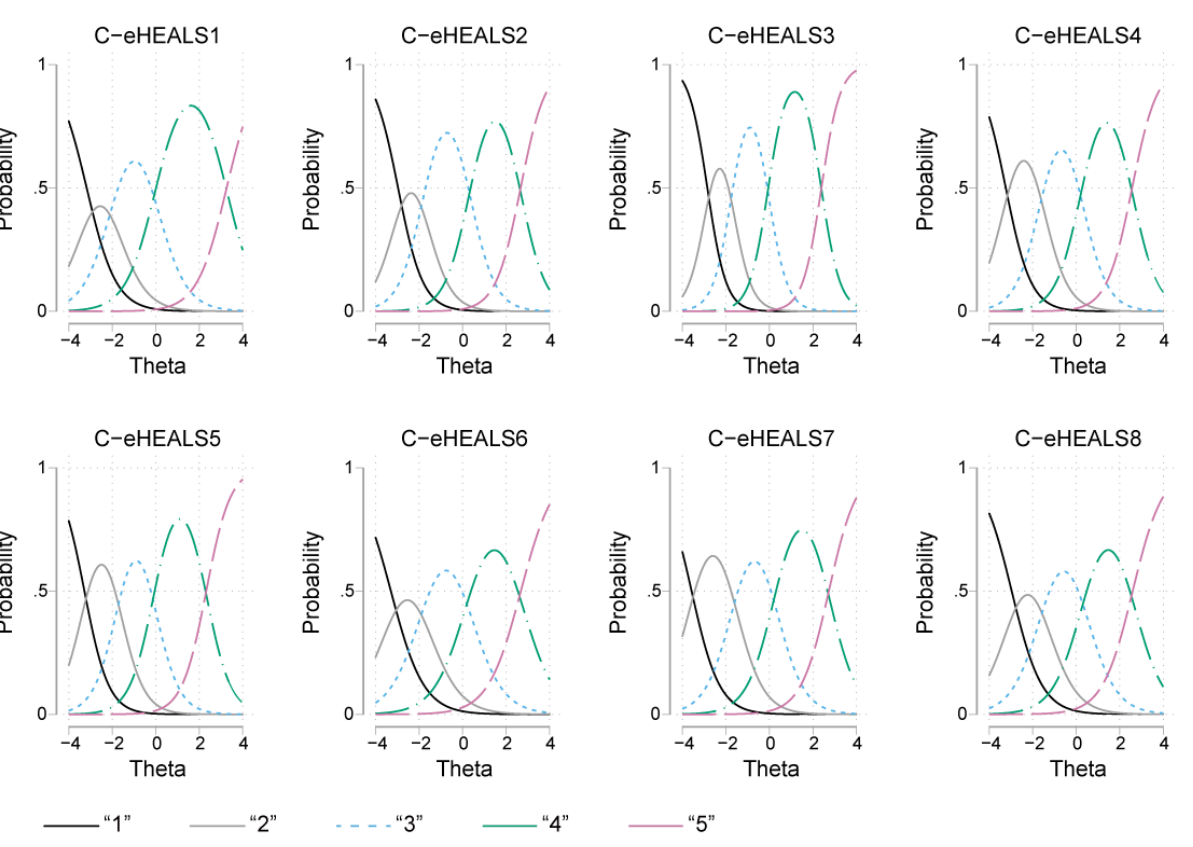
Figure 2. Item characteristic curves for each Chinese version of the eHealth Literacy Scale. Curves indicate the probability of participants at varying levels of eHealth literacy. C-eHEALS: Chinese version of the eHealth Literacy